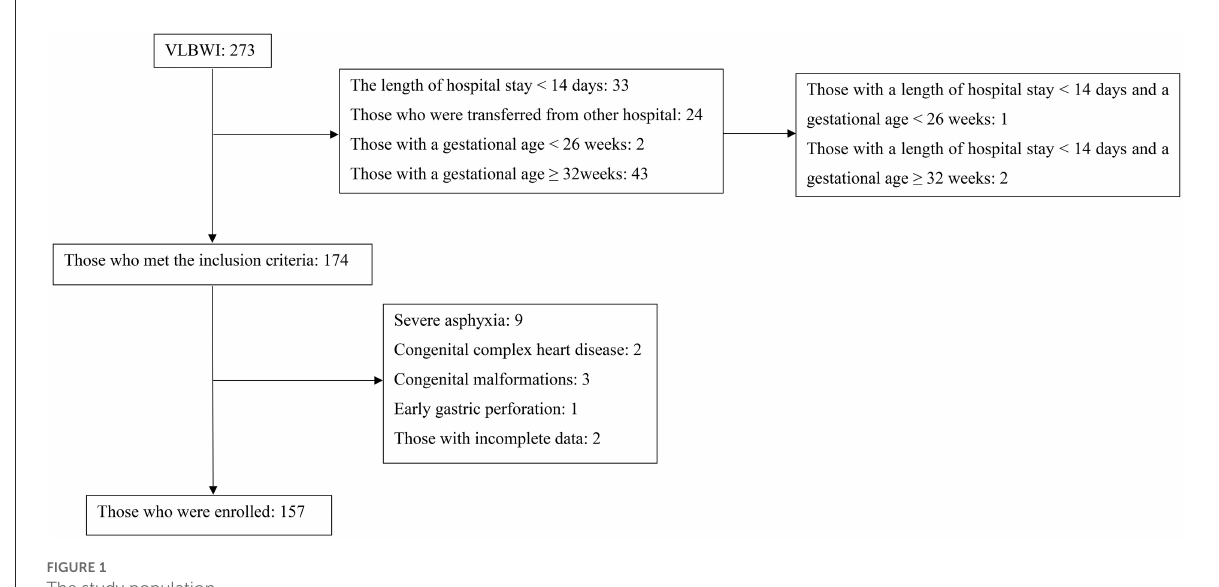
FIGURE1 The study